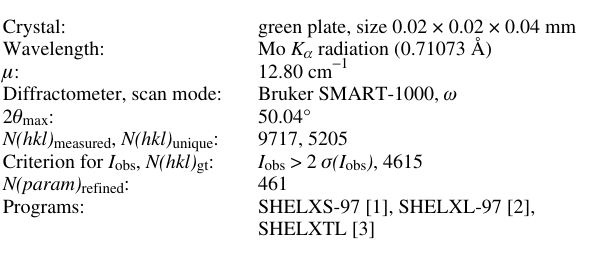
Table 1. Data collection and handling.